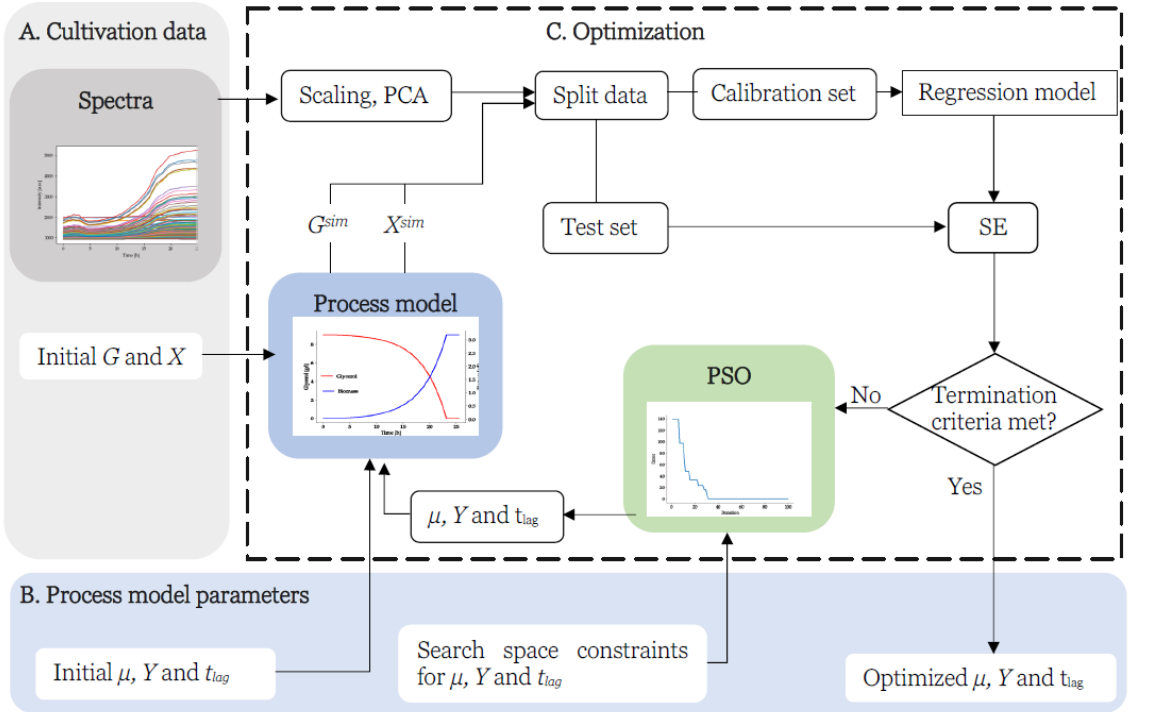
Figure 2. Illustration of model-based calibration procedure to obtain optimized process parameters and chemometric model from 2D fluorescence spectra and initial glycerol ( G ) and biomass ( X ) shown in section ( A ) No other information from actual cultivations is required. Section ( B ) serves as input for the main optimization cycle carried out in section ( C ) with the initial parameters for the theoretical process model and the corresponding search space constraints. PSO is performed to find optimum process parameters and chemometric models with the objective of minimizing the sum of errors (SE). The embedded graphs are only for visualization purposes; they do not represent actual results.